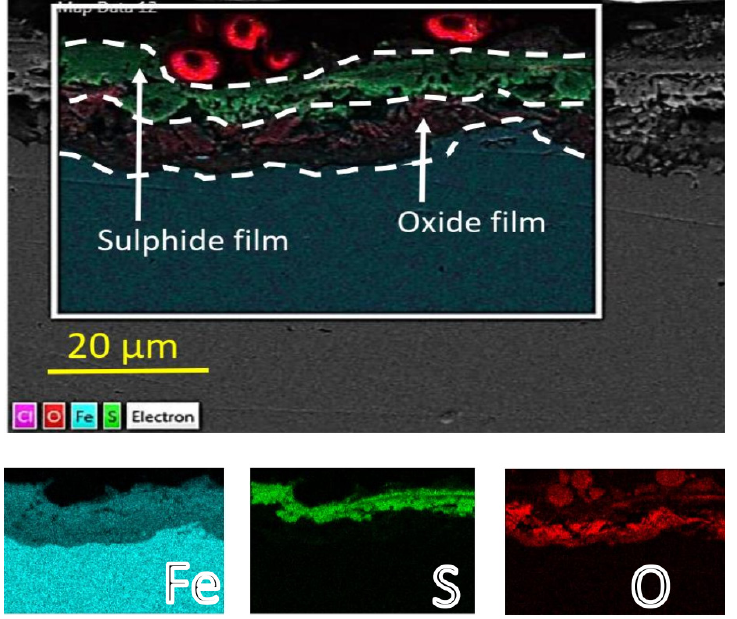
Figure 12. Elemental scanning of cross-section 1 cm from the outlet end of tested carbon-steel sample 9 at the end of the last reactor (condenser).